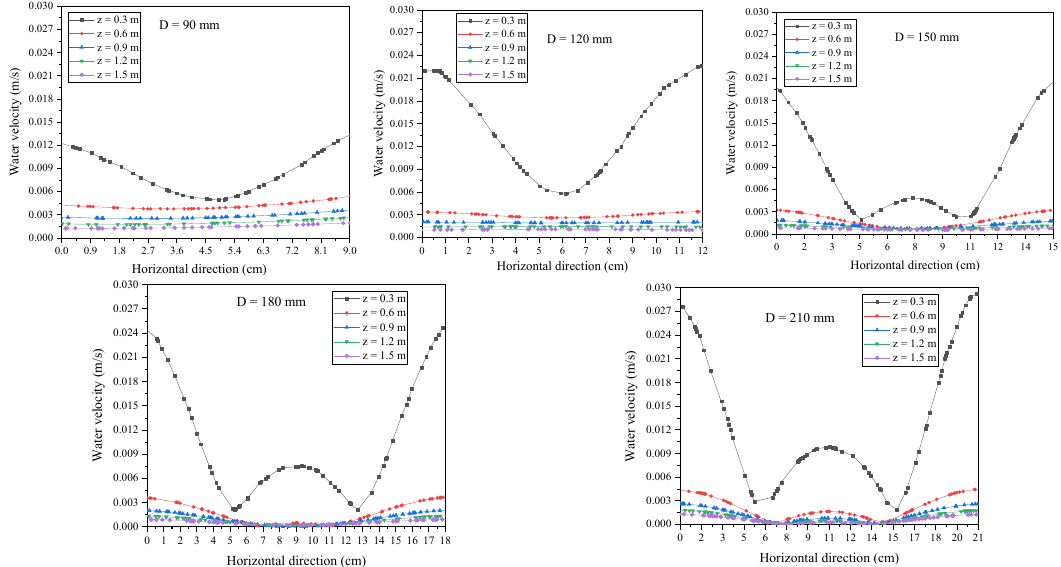
Figure 14. Water velocity variation along the horizontal direction at different orifice spacings.